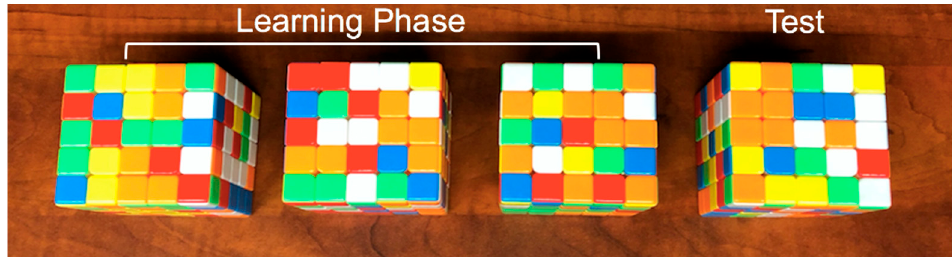
Figure 1. Consistent-order condition. Cube sizes are identical across the learning phase and at test (5 × 5 × 5).